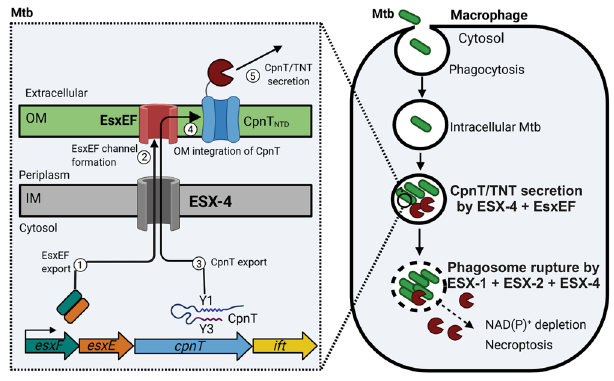
Fig. 6 Model of CpnT export and TNT secretion and traf fi cking by M. tuberculosis . After phagocytosis Mtb is trapped inside the phagosome and expresses the esx-4 genes and the cpnT operon. The ESX-4 core complex is assembled in the inner membrane (IM). Then, the EsxEF complex is exported (1) by the ESX-4 system and forms a pore in the outer membrane (OM) (2) as shown previously 8 . CpnT is exported through the ESX-4 system, possibly involving the ESX Y3 motif (3). CpnT is then integrated into the outer membrane by an unknown mechanism (4). After translocation of its C-terminal NAD + glycohydrolase domain to the cell surface, possibly via the ESX motif Y3, CpnT/TNT is secreted (5). CpnT/ TNT traf fi cking into the macrophage cytosol requires the permeabilization of the phagosomal membrane by the three type VII secretion systems ESX- 1, ESX-2, and ESX-4. TNT access to the cytosol results in NAD(P) + depletion and activation of necroptotic cell death as shown previously 7 . Figure was created using